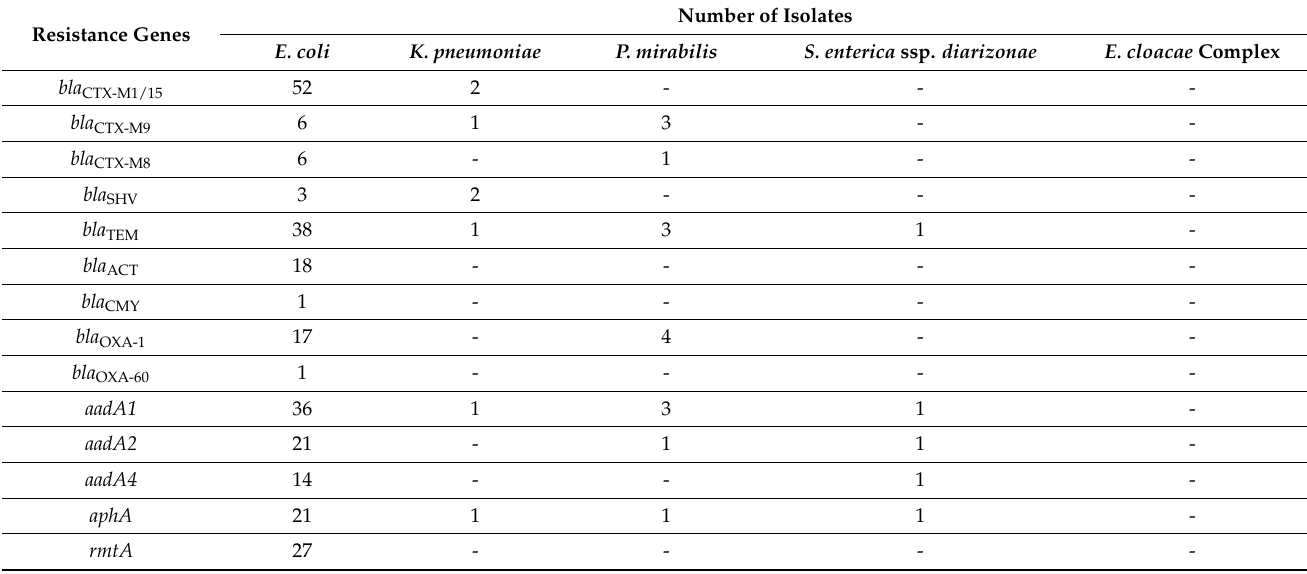
Table 4. Resistance genes detected among the ESBL-producing Enterobacteriaceae.